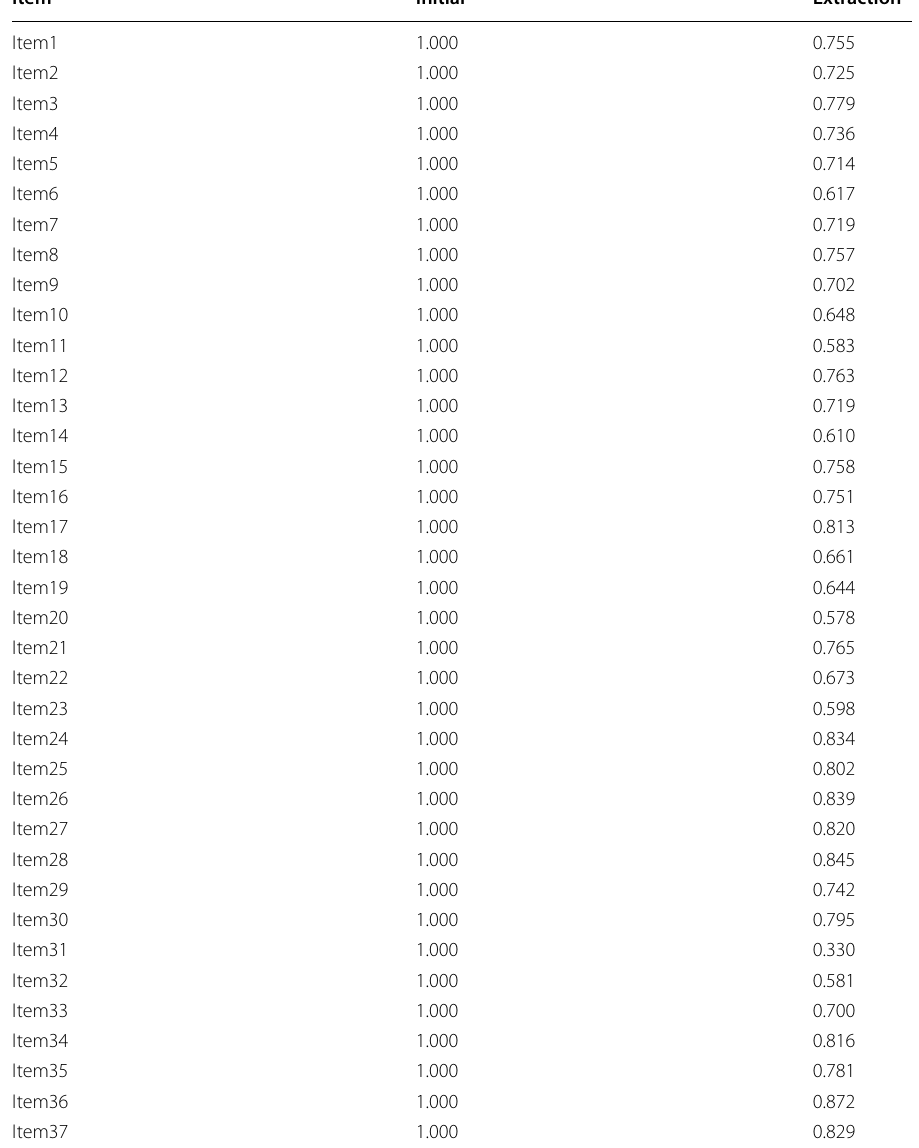
Table 3 Initial communality values in